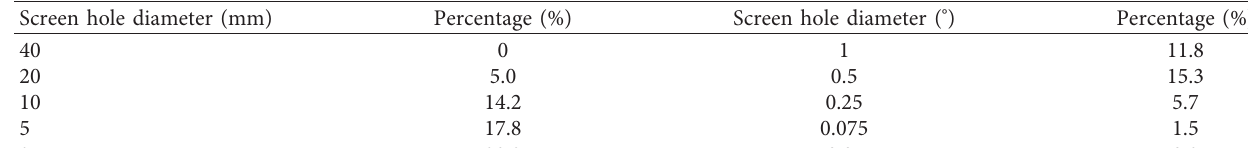
Figure 2: Landscape of studied slope: (a) before slope protection; (b) after planting plants. Table 1: Results of sieving analysis test.